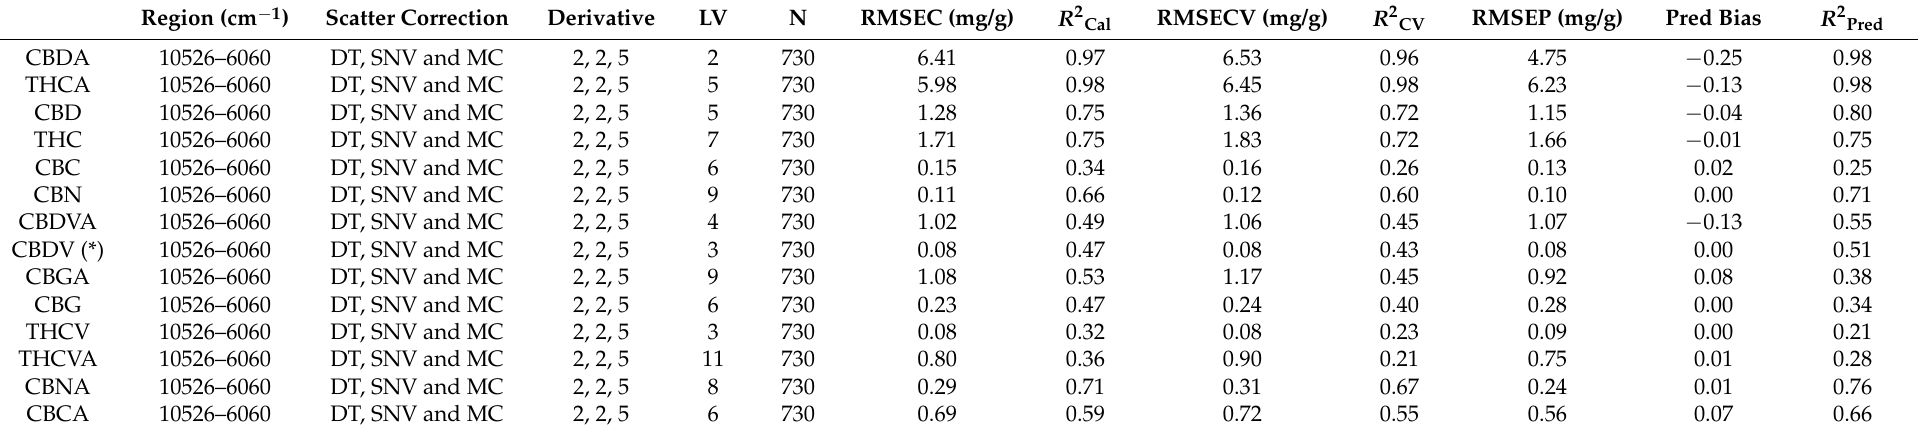
Table 4. The different pre-processing methods applied to partial least squares regression models (PLS-R) for the determination of cannabinoid compounds using data from the VIAVI MicroNIR Onsite-W instrument.